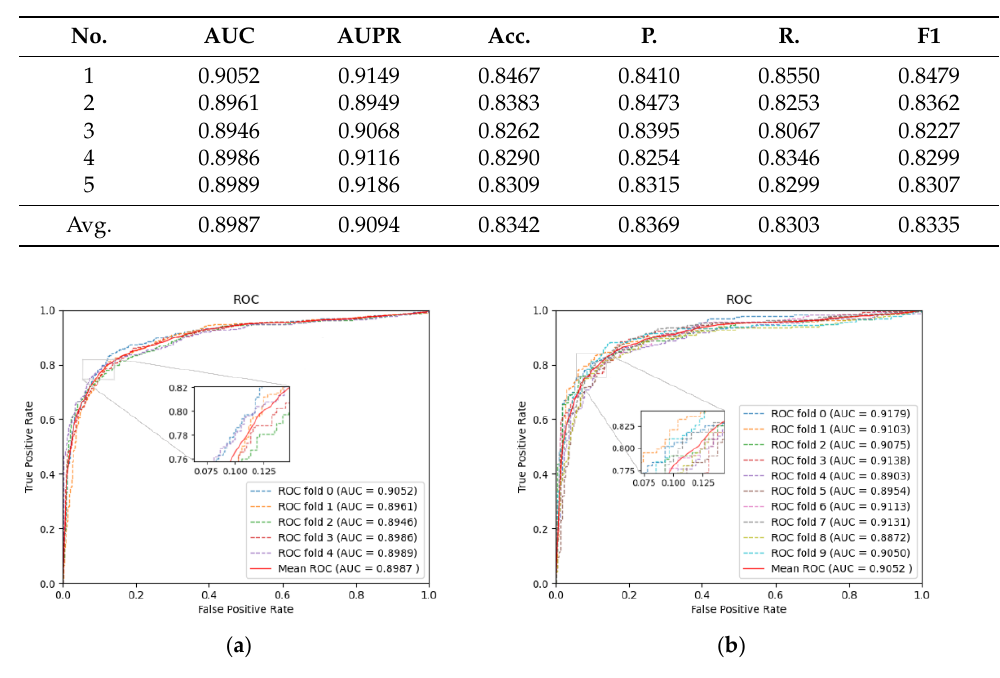
Figure 2. Performance of LRGCPND in five-fold CV and ten-fold CV, respectively. ( a ) ROC curves yielded by LRGCPND in five-fold CV. ( b ) ROC curves yielded by LRGCPND in ten-fold CV.